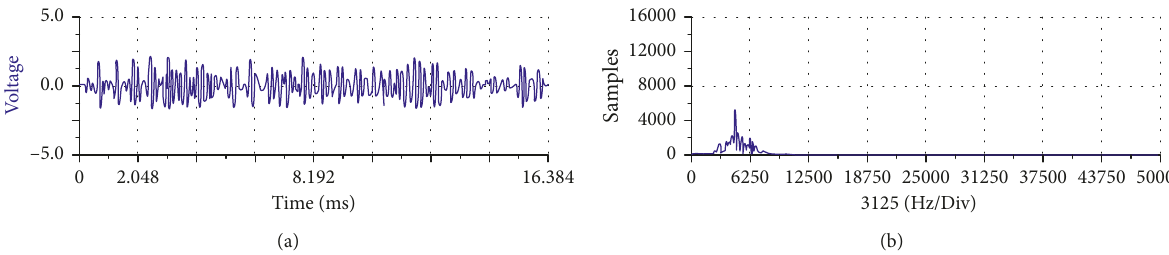
Figure 6: AE signal with slight rub impact. (a) AE waveform the in time domain. (b) AE waveform in the frequency domain.